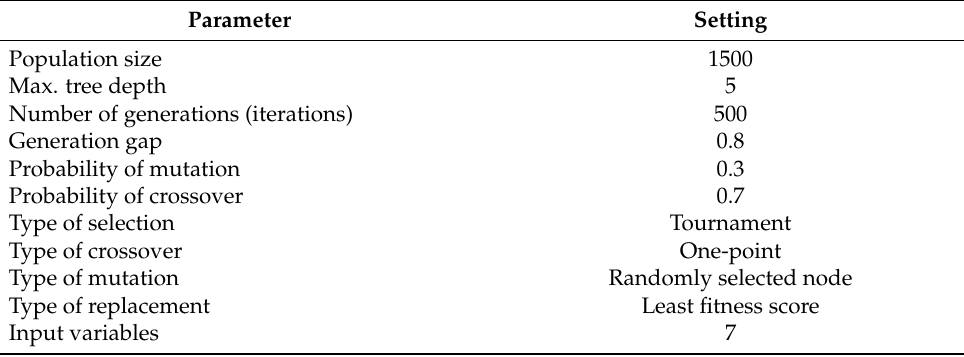
Table 10. GP parameters used in development of the RF